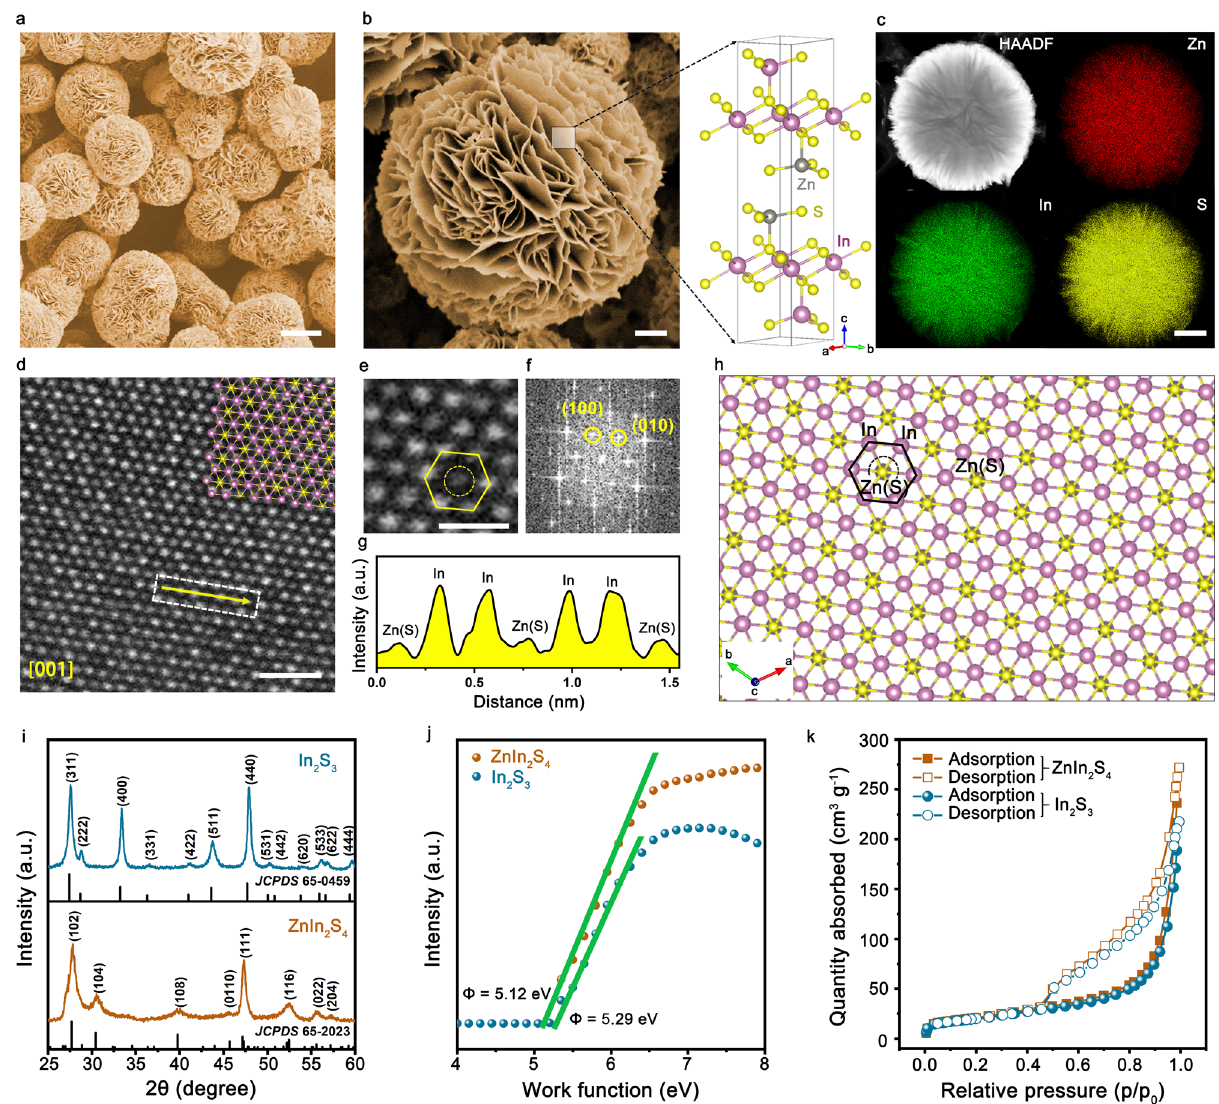
Fig. 1 Physical characterization of ZnIn 2 S 4 . a , b SEM images of the ZnIn 2 S 4 catalyst. The right panel in b shows the crystal structure of ZnIn 2 S 4 . Scale bars, 5 μ m ( a ) and 1 μ m ( b ). c STEM-EDX elemental mapping of ZnIn 2 S 4 , exhibiting a uniform spatial distribution of Zn (red), In (green), and S (yellow), respectively. Scale bar, 1 μ m. d , e Atomic-resolution Z-contrast images of ZnIn 2 S 4 along [001] zone axis. Scale bars, 1 nm ( d ) and 0.5 nm ( e ). f The corresponding FFT pattern of ( d ). g The line intensity pro fi le acquired along the yellow arrow in ( d ). h Atomic model of ZnIn 2 S 4 along [001] zone axis. i – k XRD patterns ( i ), UPS spectra ( j ), and BET surface area analysis ( k ) of ZnIn 2 S 4 and In 2 S 3 ,